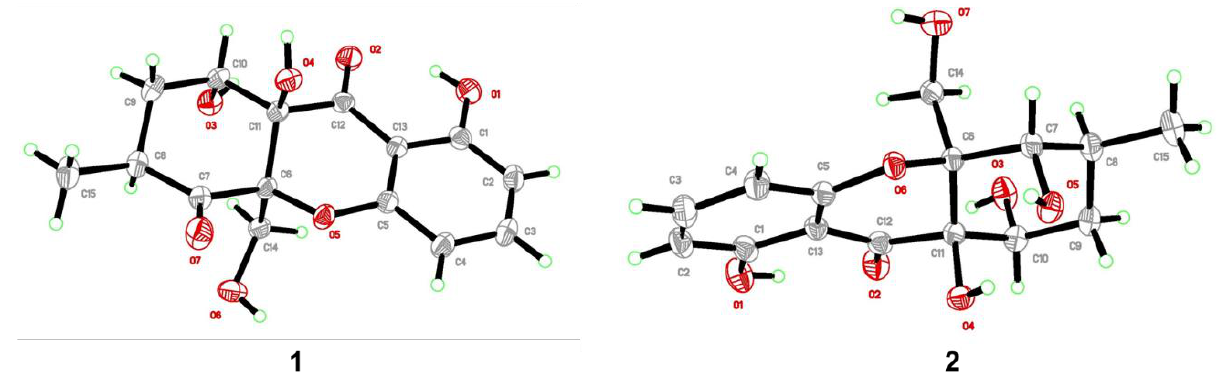
Figure 4. X-ray crystallographic structures of 1 and 2 .